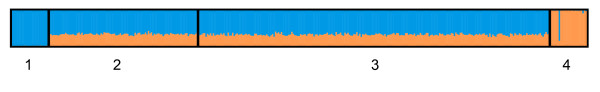
STRUCTURE admixture plot. STRUCTURE clearly delineates the two populations used to define the AIMs genotyped in the present study, the southern Han Chinese (1) and highland Papua New Guineans (4). Speakers of Austronesian and Papuan languages in North Maluku (groups 2 and 3, respectively) show a uniform degree of Asian admixture and no evidence of genetic differentiation. (Note the single individual with substantial Asian admixture in the highland Papua New Guinea sample).